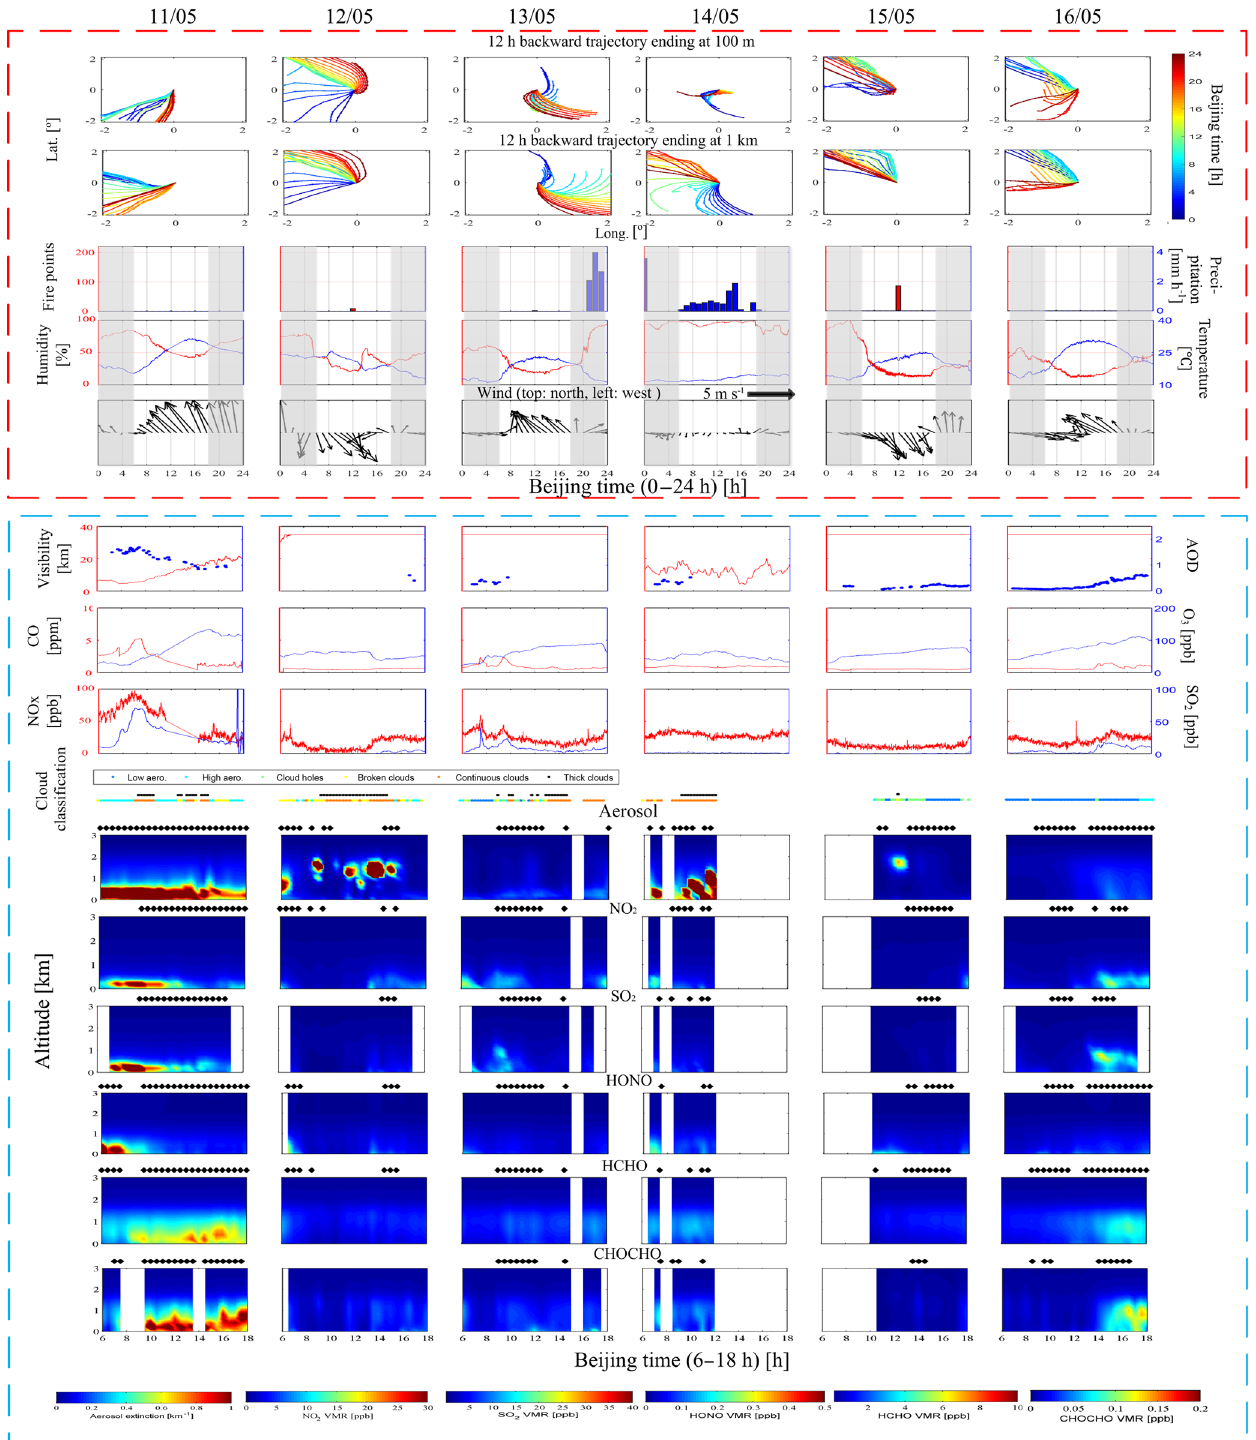
Figure 10. Results from MAX-DOAS measurements, trajectories, meteorological data and independent measurements of pollutants during the period from 11 to 16 May 2016. The figures surrounded by the red and blue dashed boxes show the values for 24h periods (red) or 12h (blue) daylight periods (06:00–18:00). The total fire points in the NCP area are derived from MODIS observations and the hourly accumulated precipitation were measured at the station (third row). In the fifth row hourly averaged local winds are given by arrows moving with the wind. The colour bars of the MAX-DOAS profiles are given at the bottom. The black rhombuses plotted above the individual subfigures of the time series of MAX-DOAS profiles mark those that are most reliable (thresholds are given in Table